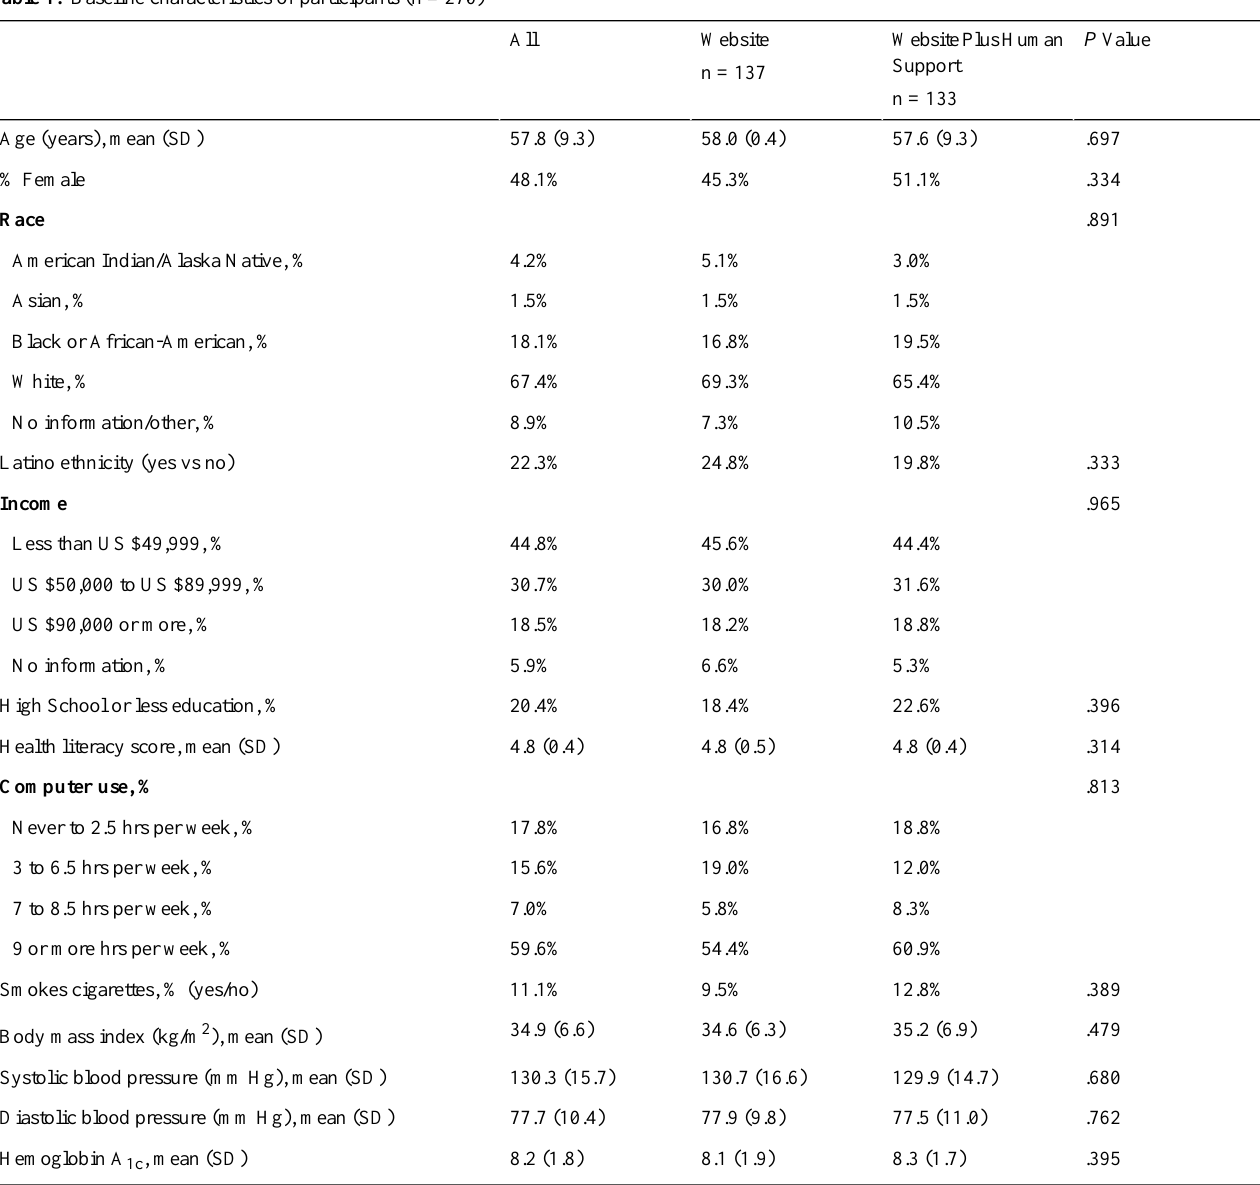
Table 1. Baseline characteristics of participants (n = 270)